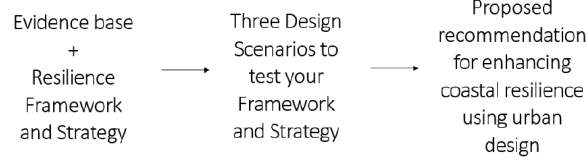
Figure 2: The four steps involved in the scenario development and testing. 1.) Development of evidence base, 2.) Development of Resilience framework and strategies, 3.) Development of Scenarios and 4.) testing and evaluation of scenarios and recommendation of more effective strategies (Image by authors)